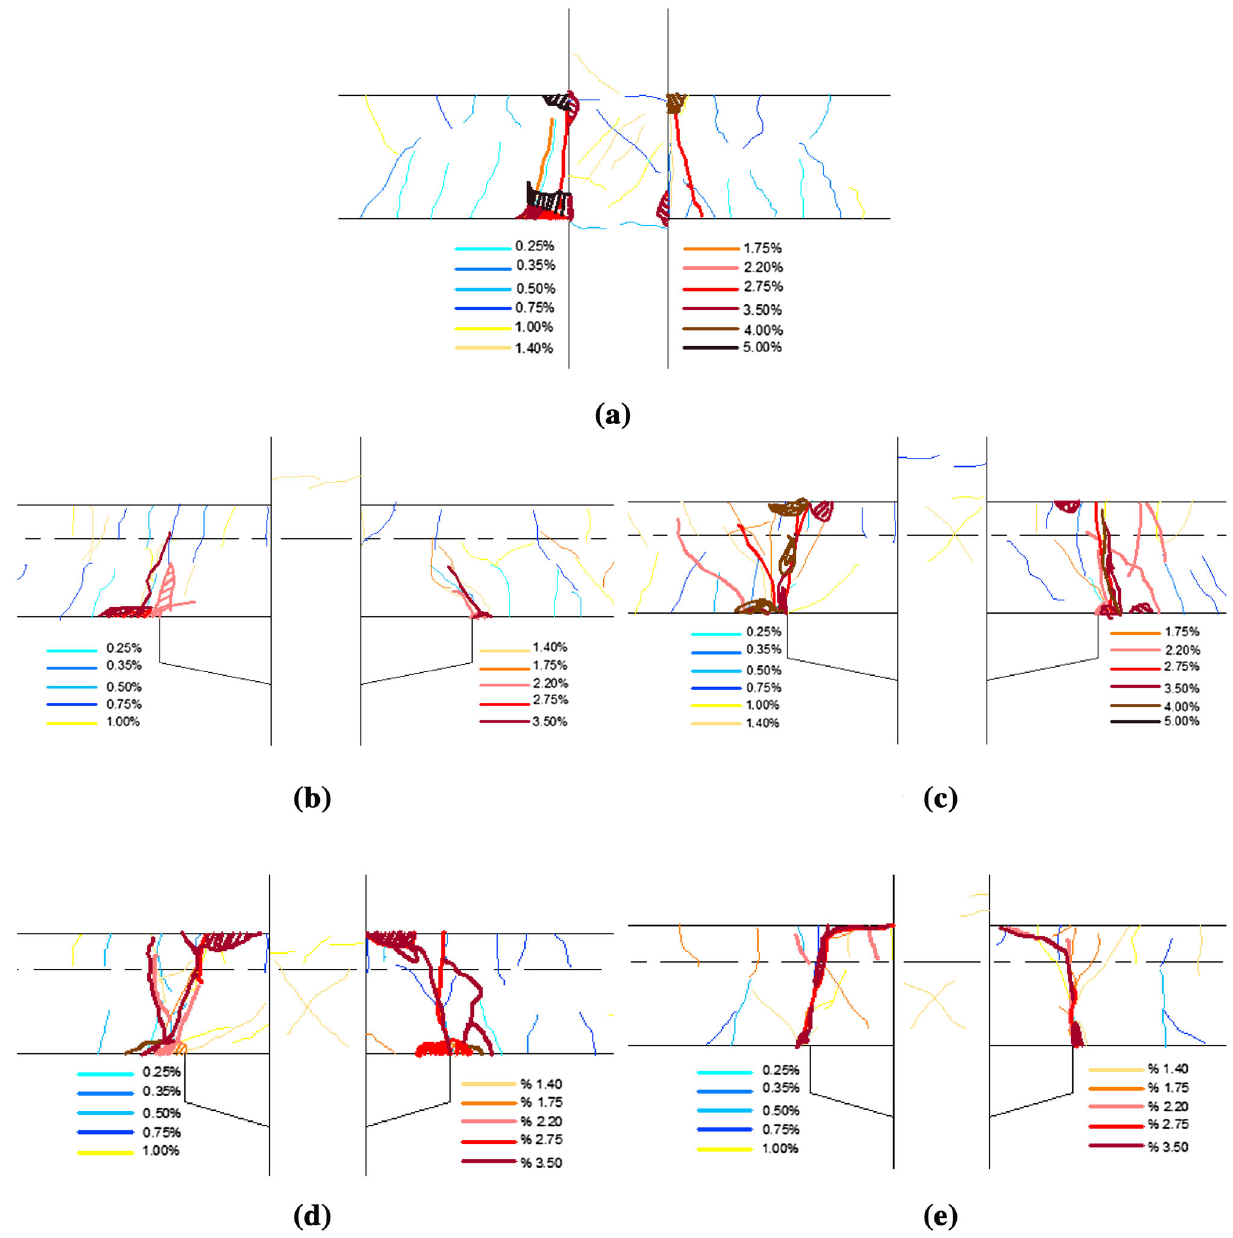
Fig. 14 Damage patterns of test specimens at each drift ratio and the end of test. a MONO, b SP1, c SP1-R, d SP3, and e SP3-R.